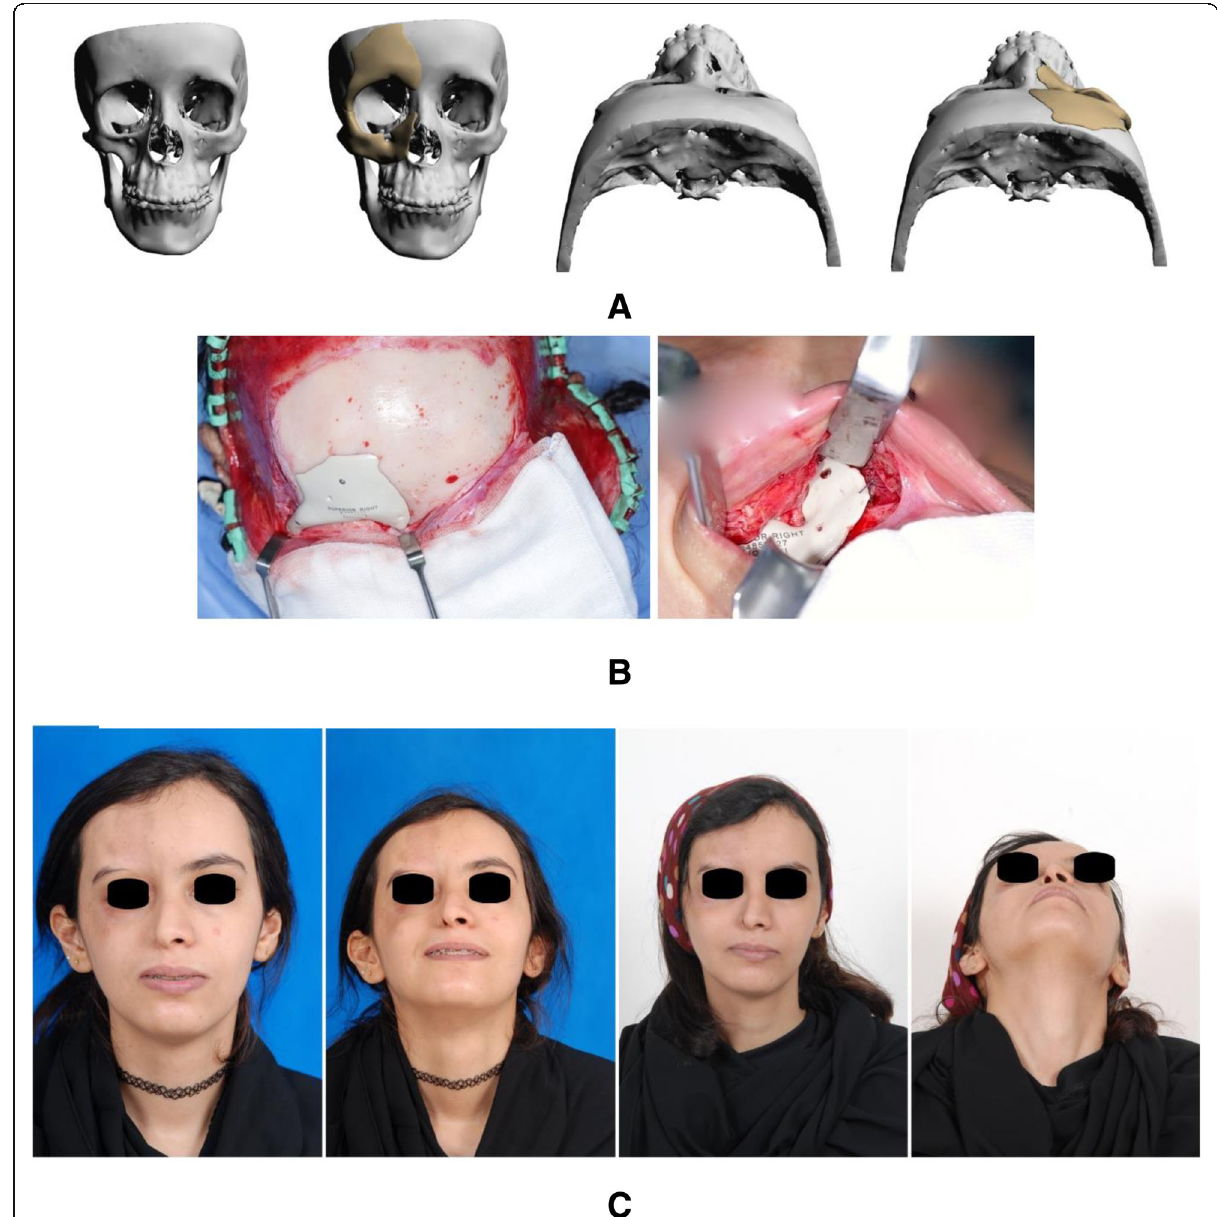
Fig. 1 Parry-Romberg syndrome case. a 3D reconstruction of the CT showing the defects and the planned implants. b Intraoperative views of the implants. c Pre- and postoperative photographs of the